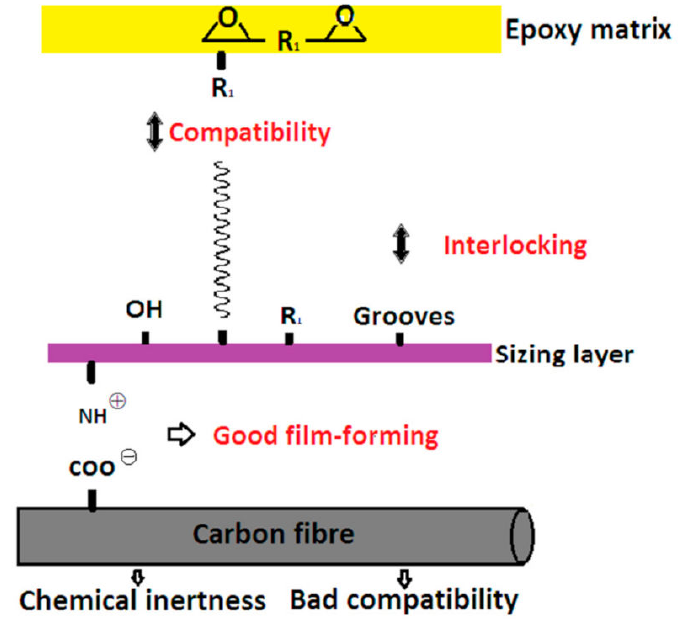
Figure 14. A schematic diagram of the interface enhancement mechanism between CFs and the epoxy